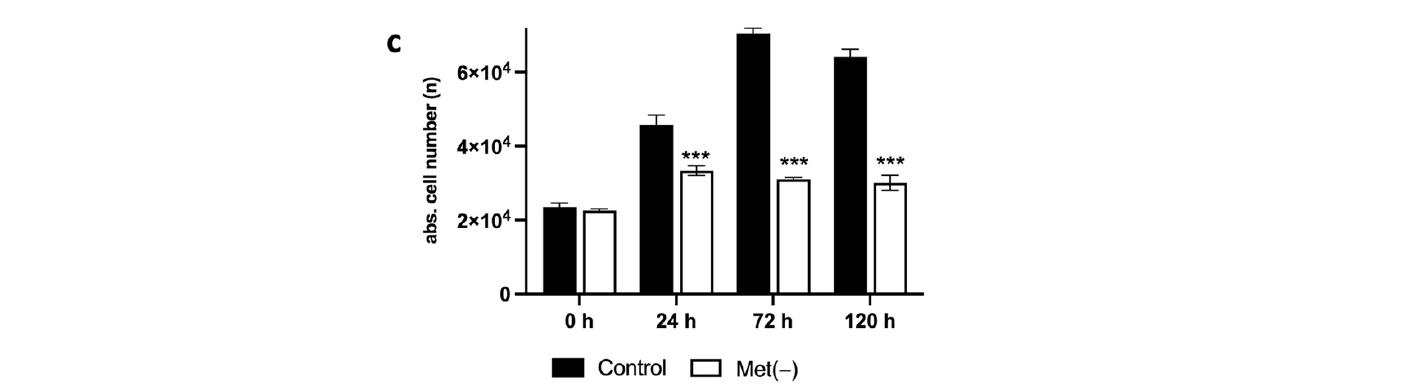
Figure 1 . ( a – c ) Proliferation analysis of L929 cells. A total of 10,000 cells were seeded per well and incubated overnight. ( a ) Absolute cell numbers were analysed via ImageXpress digital microscopy as described in the Materials and Methods. The figures show a summary of the results obtained from four independent experiments (six values for every group per experiment); ( b ) trend curve of the values from figure ( a ) showing exponential growth. Values that do not represent exponential growth are shown as red dots; ( c ) L929 cells were stimulated for 24, 72, and 120 h with or without methionine. Cell proliferation was analysed via ImageXpress digital microscopy analysis as described in the Materials and Methods. The figure shows one representative experiment (five values for every group), as published previously [17] . Comparisons between the control and Met( − ) groups were performed by applying one-way ANOVA followed by the Tukey–Kramer multiple comparison test (*** p < 0.001).